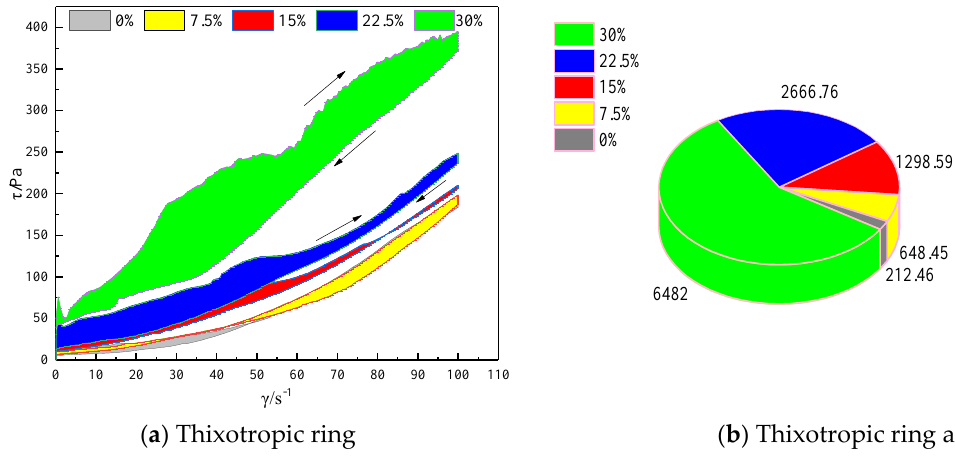
Figure 7. Thixotropic characteristics.